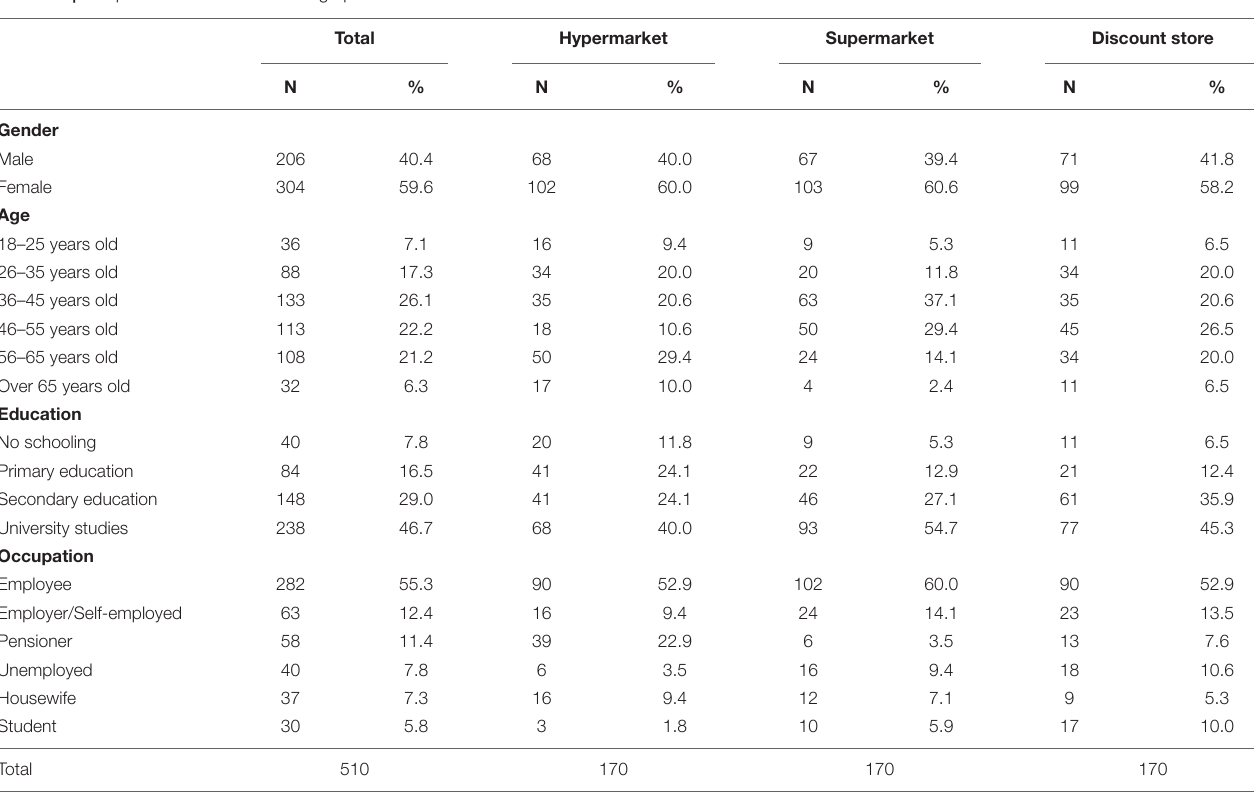
TABLE 1 | Sample distribution: sociodemographic